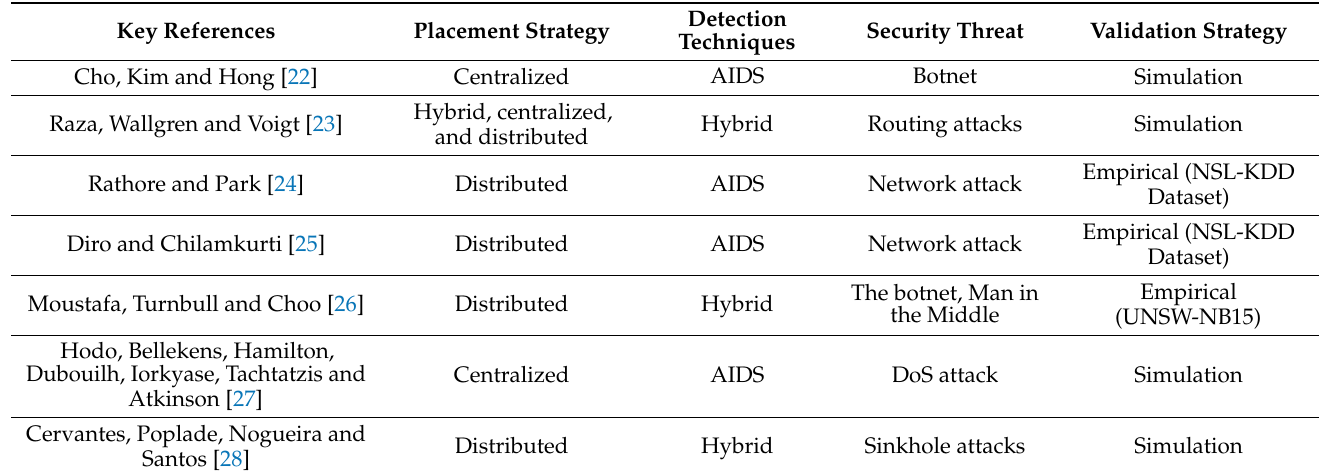
Table 1. Summary of the proposed research on IDSs for IoT.